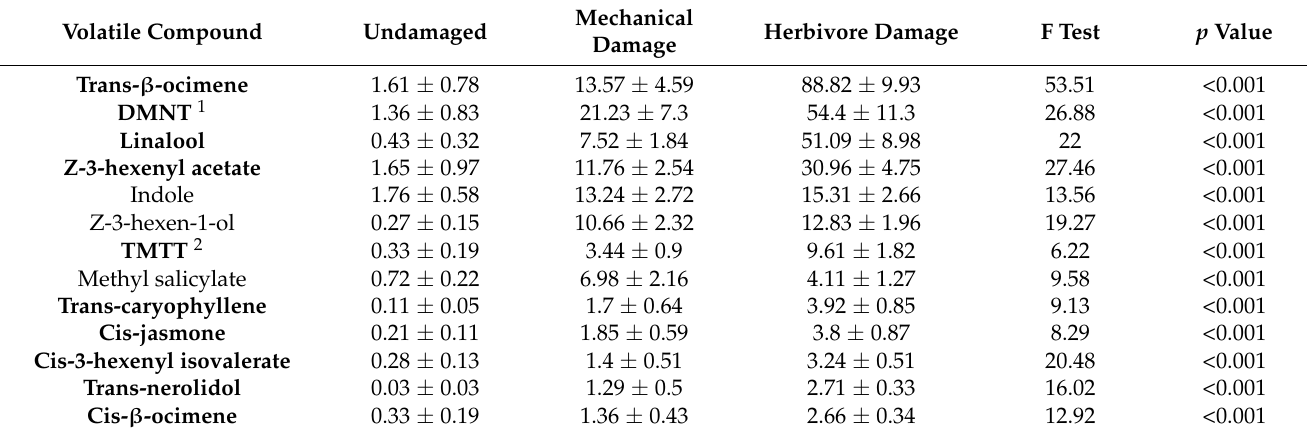
Table 2. Means ± SEs of individual compound emissions (ng/6 h/plant) averaged over three populations of P. Lunatus (Flores, Inka, Yel) from three damage treatments, including an undamaged control. Only compounds that were found to be significantly different from the undamaged treatment are included. Bolded compounds indicate those that were significantly higher in the herbivore damage than mechanical damage treatment. Tukey HSD tests were used to assess pairwise significance.